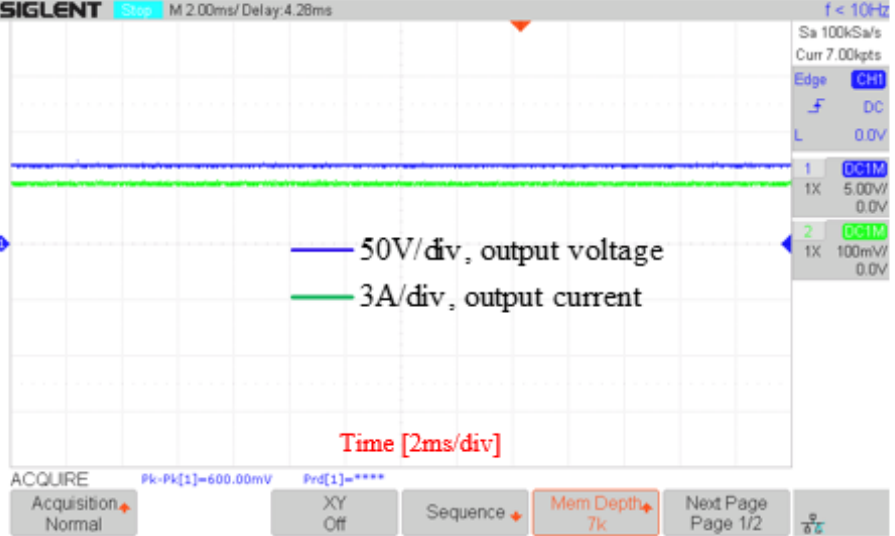
Figure 36. Load voltage and load current waveforms when removing cell 3.